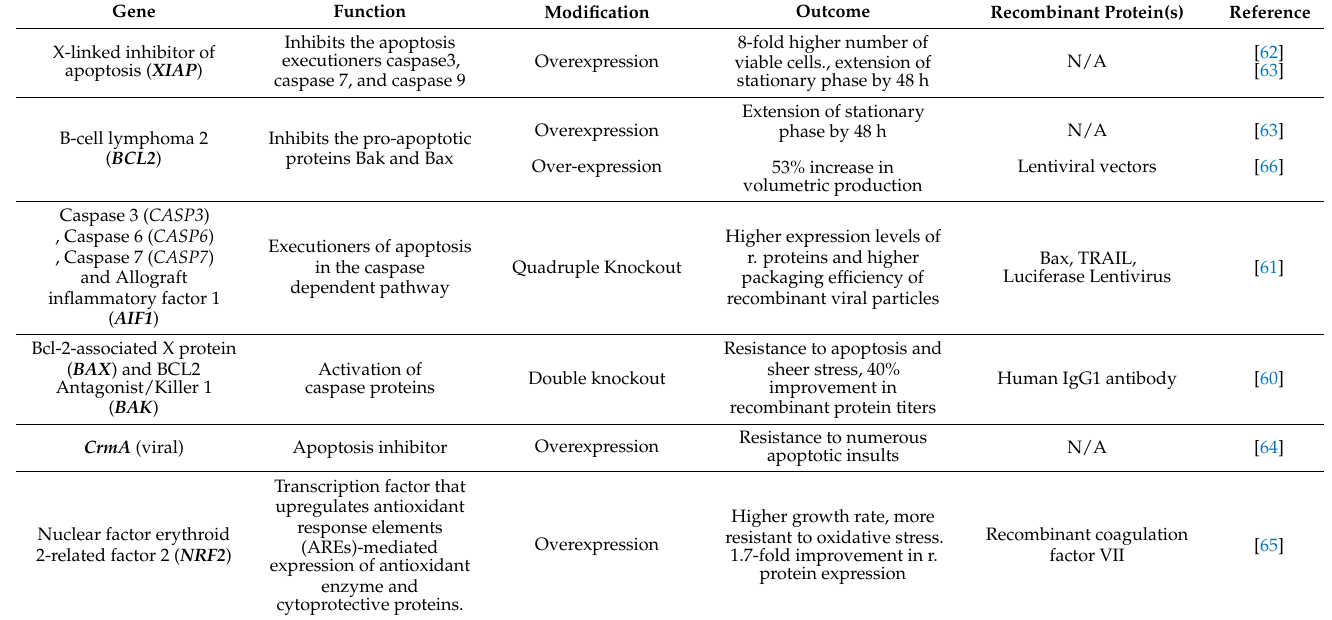
Table 3. Genes that have been engineered to delay apoptosis in the HEK293 cell